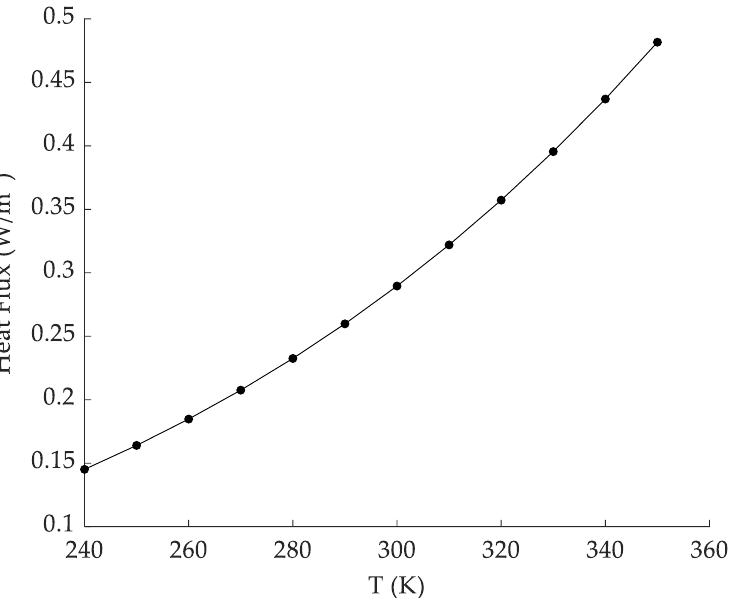
Figure 9. Variation in heat flux with thermal boundary temperature.